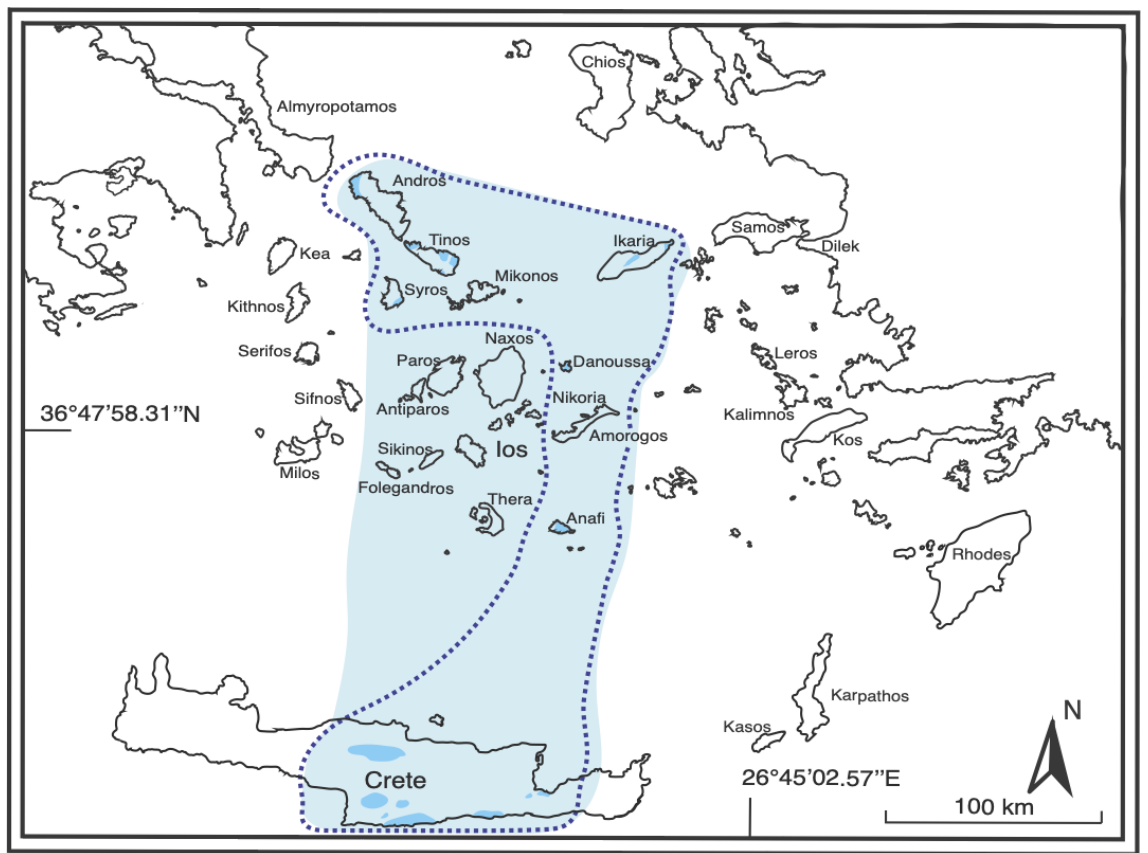
Figure 1. Map of the Cyclades and Crete, dotted line illustrates published extent of the Asteroussia nappe: area enclosed with the dashed line includes outcrop localities with late Cretaceous age (with information retrieved from Be’eri-Shlevin et al., 2009). The area shaded in light blue is the revised areal extent of the Asteroussia nappe suggested in this